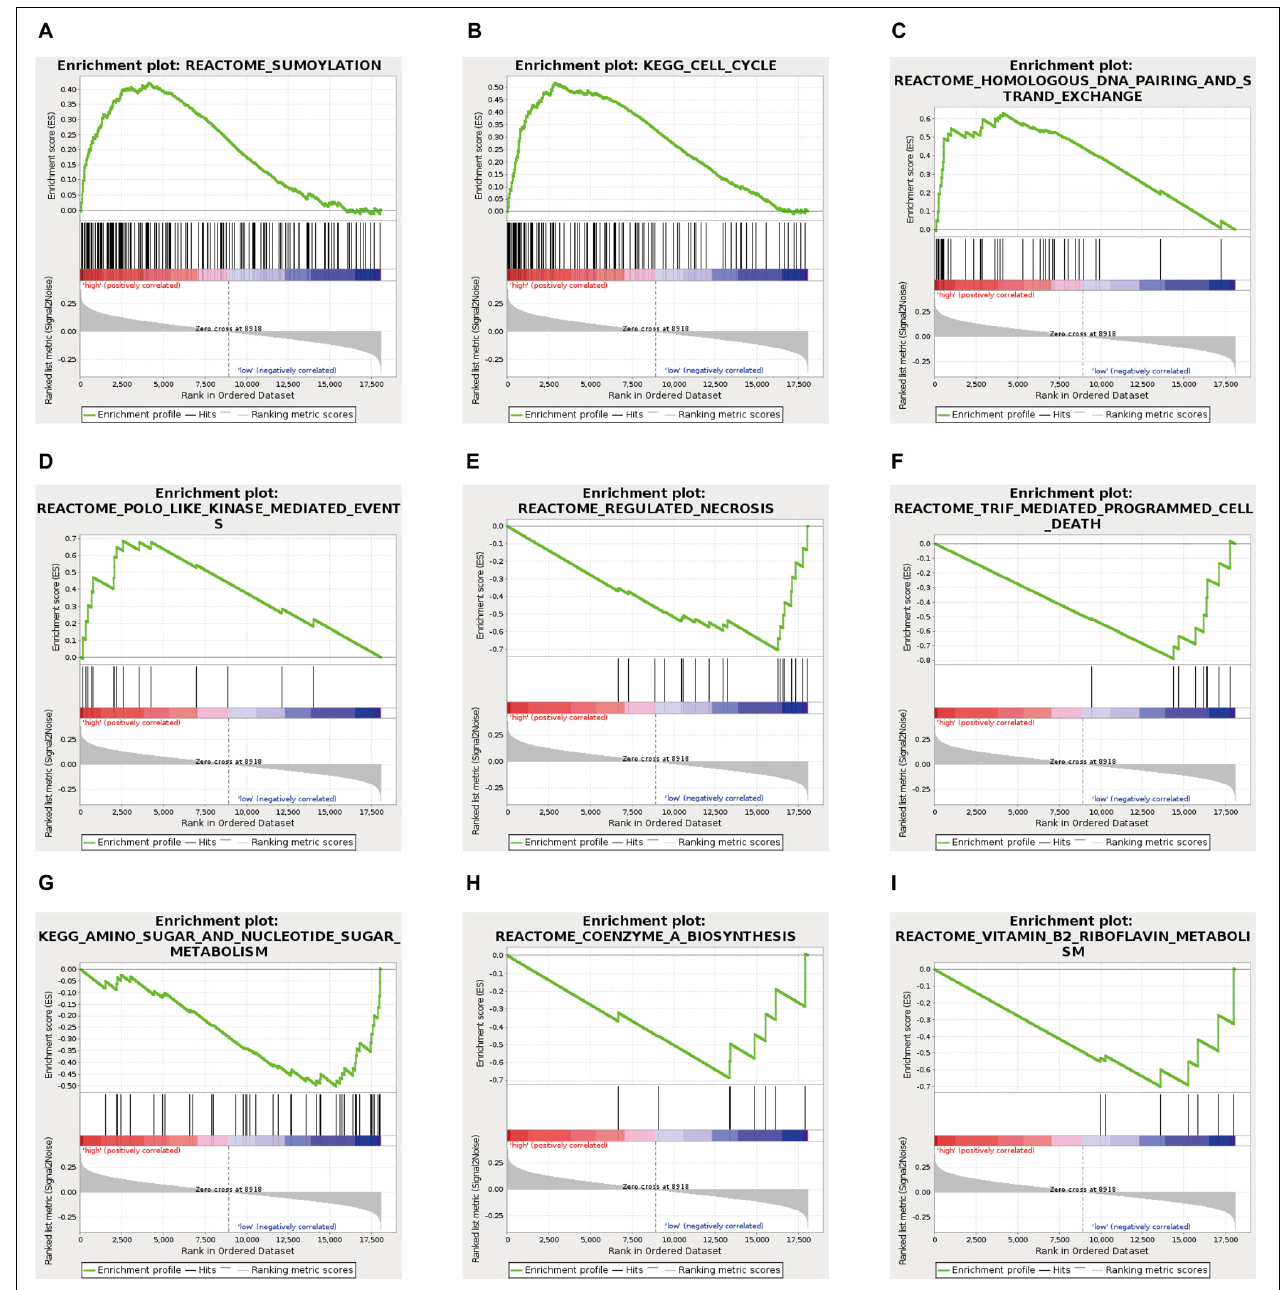
FIGURE 7 | Gene set enrichment analysis analysis delineates biological pathways correlated with the final ES AS event-based classifier using. Hallmark gene sets in “C2: Canonical pathways” section of MSigDB database. The TNBC cohort was classified into low- and high-risk subgroups by ES AS pattern. Significantly enrichment results from GSEA were refer to “SUMOylating,” “Cell cycle,” “Homologous DNA pairing and strand exchange,” POLO like kinase mediated events,” “Regulated necrosis,” “TRIF mediated programmed cell death,” “Amino sugar and nucleotide sugar metabolism,” “Coenzyme A biosynthesis,” and “Vitamin B2 riboflavin metabolism” ( A–I , see detailed information in Supplementary Table 4